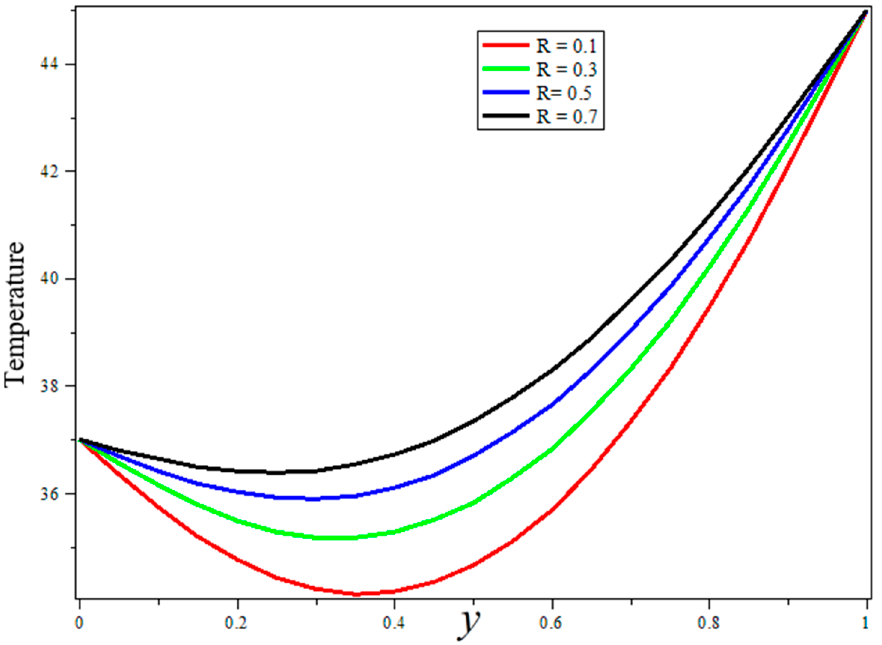
Figure 1. The influence of radiation parameters on the temperature field during tumor hyperthermia therapy.